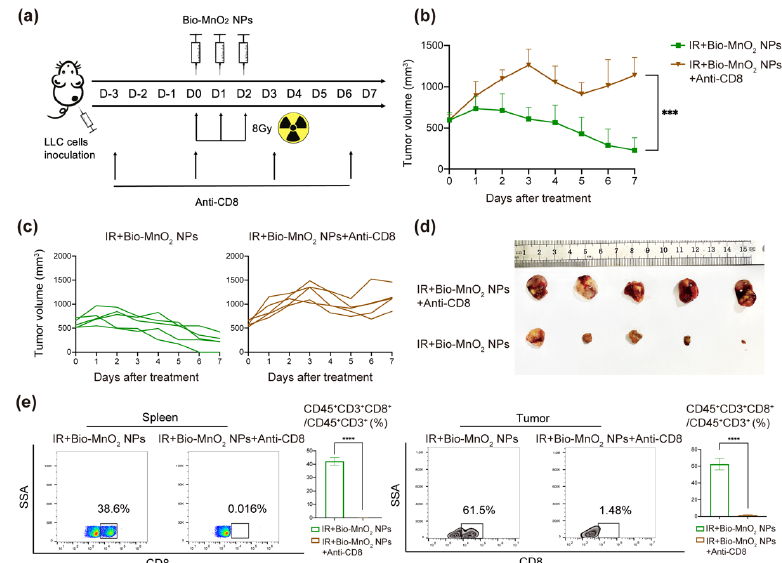
Figure 9. Cytotoxic T cells played an important role in immune responses activated by Bio-MnO 2 NPs plus radiation in vivo. ( a ) Schematic illustration of the experiment in vivo. ( b ) Growth curve of tumor volume after different treatments: IR + Bio-MnO 2 NPs, IR + Bio-MnO 2 NPs + Anti-CD8. ( c ) Tumor growth curve of each mouse. ( d ) Representative images of tumors. ( e ) Flow cytometry analysis of cytotoxic T cells in spleen and tumor tissues. ***, p < 0.001; ****, p <